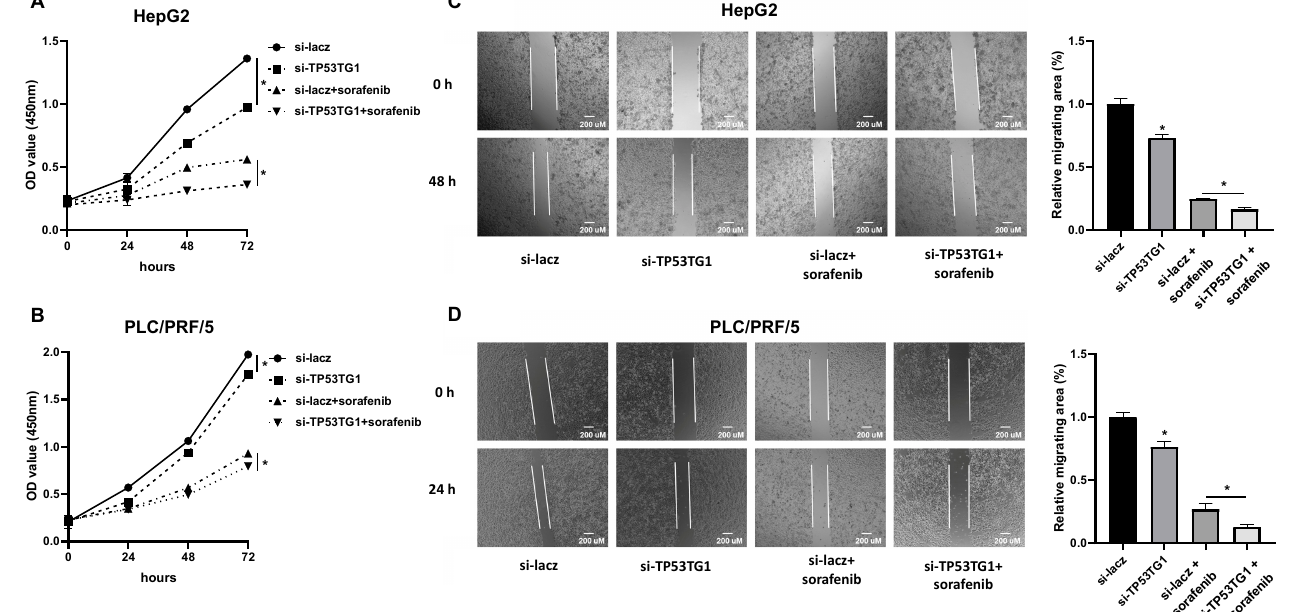
Figure 3. Knockdown of TP53TG1 improves the effect of sorafenib on HCC cell proliferation and migration. ( A , B ) Proliferation rate of ( A ) HepG2 and ( B ) PLC/PRF/5 cells treated with si-lacz, si-TP53TG1, si-lacz + sorafenib, and si-TP53TG1 + sorafenib ( n = 6); ( C , D ) Cell migration rate in ( C ) HepG2 and ( D ) PLC/PRF/5 cells treated with si-lacz, si-TP53TG1, si-lacz + sorafenib, and si-TP53TG1 + sorafenib. Error bars are shown as SEM, * p < 0.05.